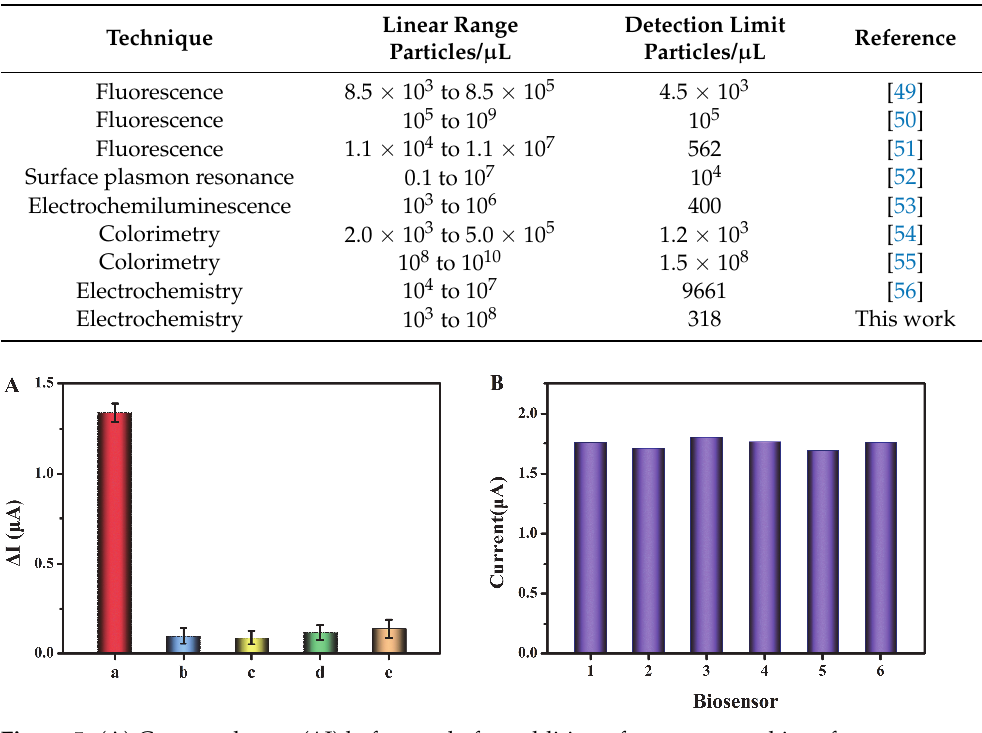
Figure 5. ( A ) Current change ( ∆ I) before and after addition of exosomes and interferents. a–e are exosome, cysteine, glucose, glutathione, and BSA, respectively. ( B ) Reproducibility of the biosensor.